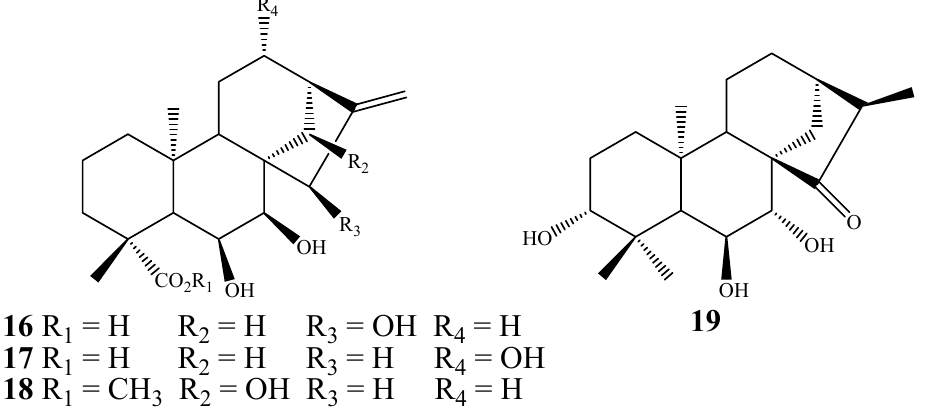
Figure 7. Chemical structures of the β , β and β , α kaurane vic-diols 16 – 19 .